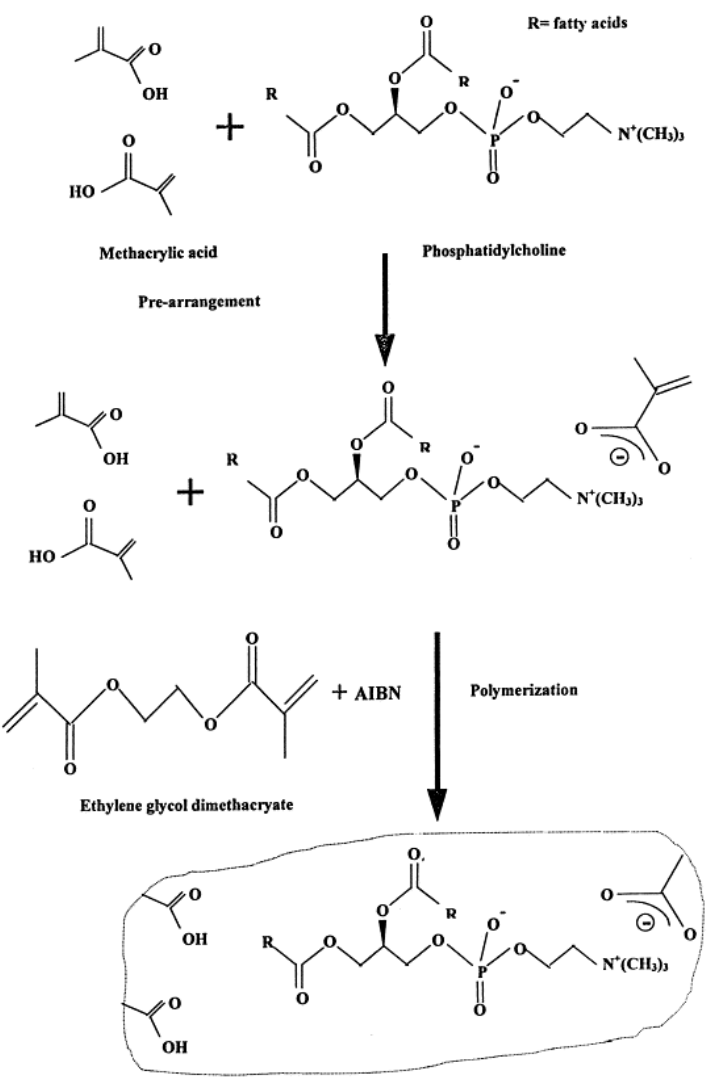
Figure 3. A schematic version of polymerization stage and preparation of polymerized lipid membranes (from Reference [19] with permission).